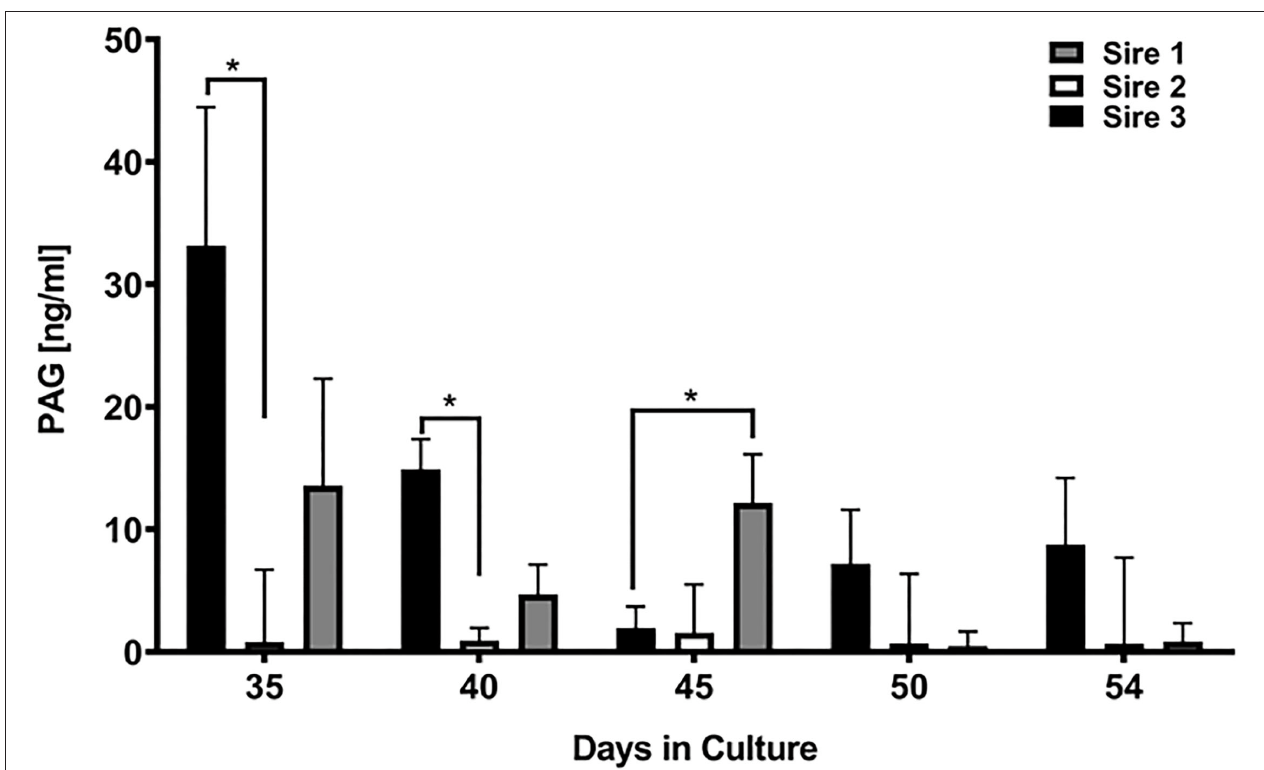
FIGURE 4 | Pregnancy associated glycoproteins (PAGs) in cell culture media. A total of 30 cell outgrowths (10 outgrowths per sire) were evaluated in an ELISA specific for BNC-secreted PAGs. Bars marked with an * above represents differences ( P < 0.05 ) between